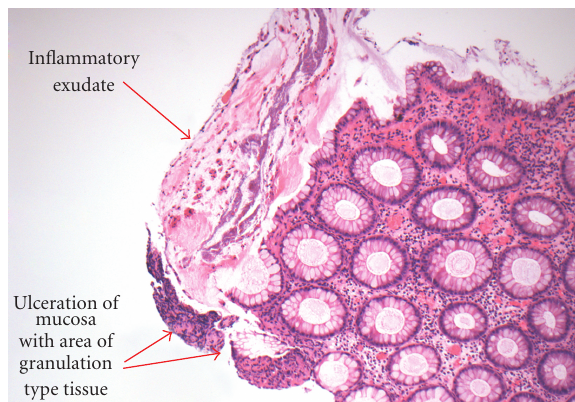
Figure 3: Colonic biopsy (10x) showing changes with exudate and ulceration (arrows) that are typical of the pseudomembrane formation seen in pseudomembranous